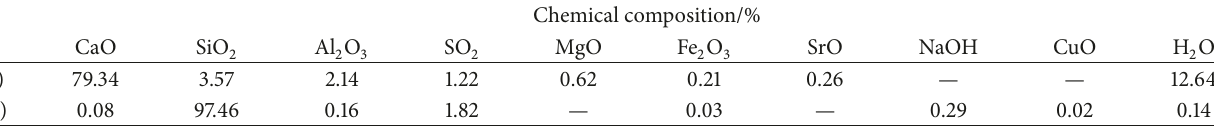
Table 1: Chemical components of carbide residue and white carbon black ((1) carbide residue; (2) white carbon black). Chemical